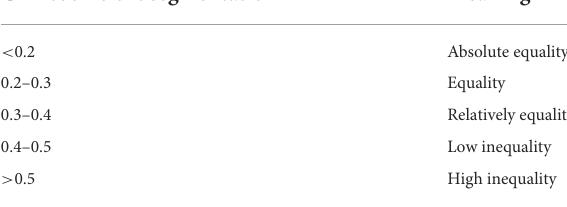
TABLE 3 Gini coefficient segmentation table showing equality in